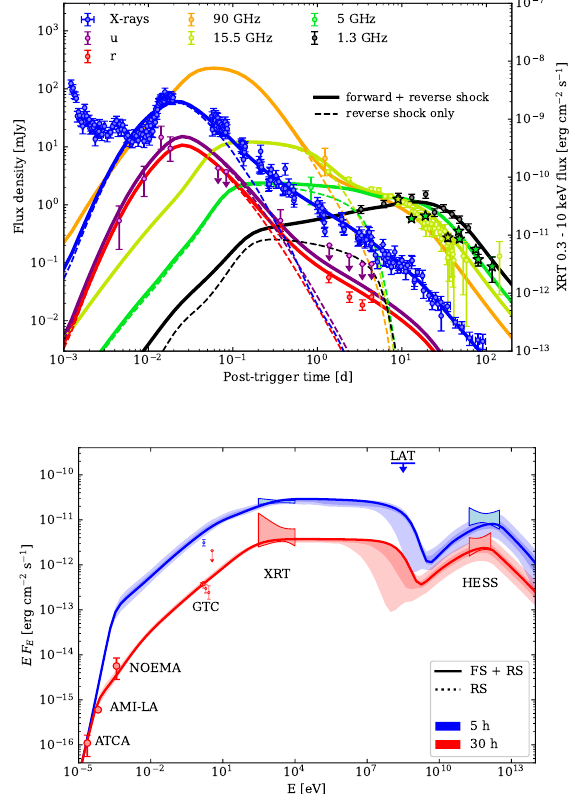
Figure 23. GRB190829A: modeling of multi-wavelength light curves ( upper panel) and SED ( bottom panel) proposed by [72]. The 90% and 50% credible intervals from the fit are shown in lighter